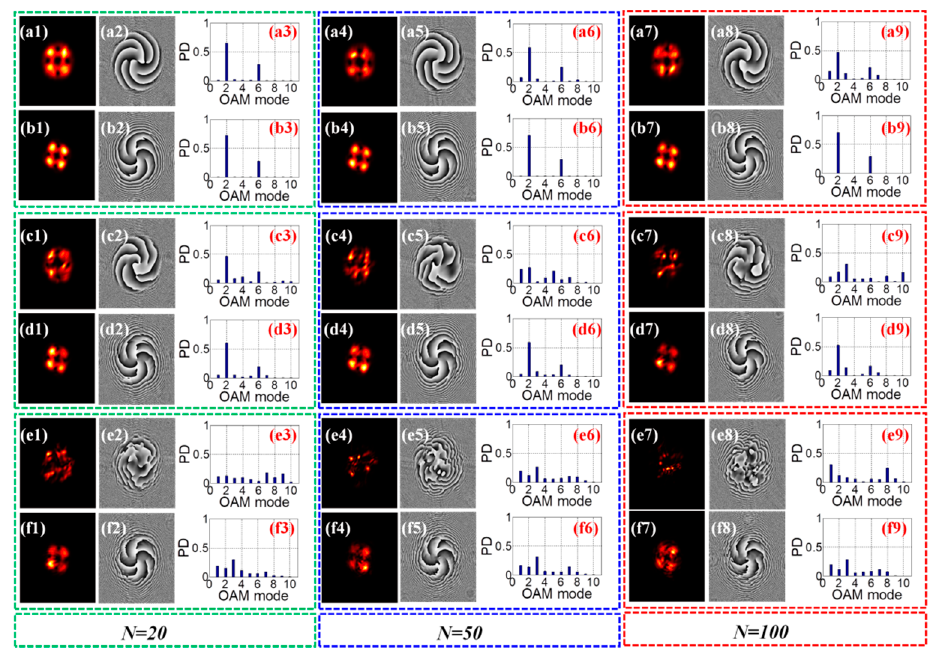
Figure 6. The intensity and phase distributions of multiplexing OAM beams ( l = 2 and l = 6) and their PD spectra without and with the pre-compensation of GS algorithm under simulated atmospheric turbulence with different refractive-index structure parameter of C 2 n valued as 1 × 10 − 15 m − 2 / 3 , 1 × 10 − 14 m − 2 / 3 and 1 × 10 − 13 m − 2 / 3 (corresponding to the first, second and third horizontal line). The parts framed in green, blue and red dashes represent random phase screens number N = 20, 50 and 100 respectively. (a1, a4, a7), (c1, c4, c7) and (e1, e4, e7) are intensity profiles without pre-compensation, (a2, a5, a8), (c2, c5, c8) and (e2, e5, e8) demonstrate their corresponding phase distributions, (a3, a6, a9), (c3, c6, c9) and (e3, e6, e9) show their corresponding PD spectra; (b1, b4, b7), (d1, d4, d7) and (f1, f4, f7) are intensity profiles with the pre-compensation of GS algorithm; (b2, b5, b8), (d2, d5, d8) and (f2, f5, f8) depict their corresponding phase distributions, (b3, b6, b9), (d3, d6, d9) and (f3, f6, f9) correspond to their PD